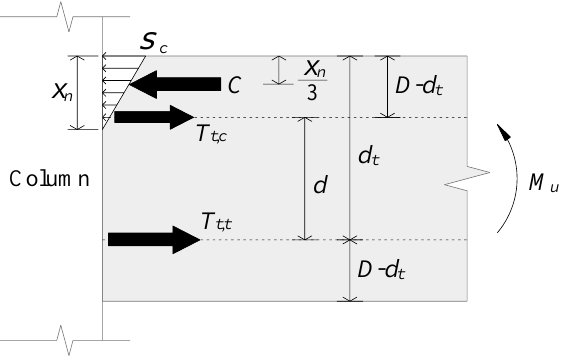
Figure 5. Constitutive model: ( a ) high-strength concrete; ( b ) tendons.